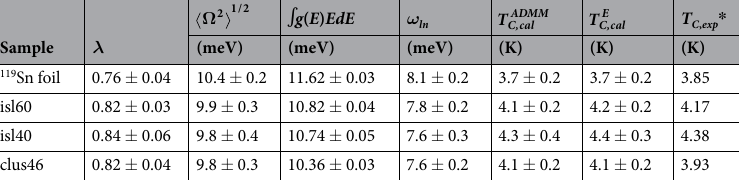
calE calculated for C ,